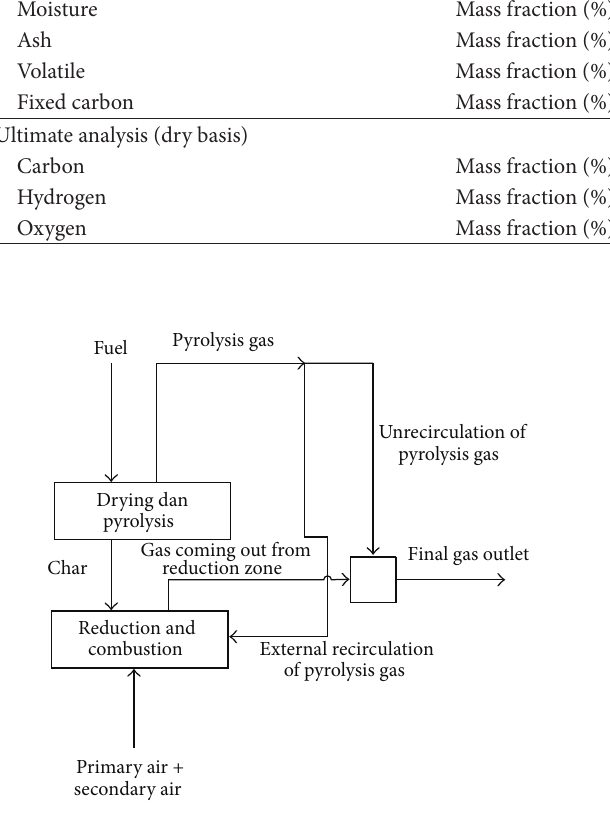
Figure 2: Configuration model updraft gasifier with external recir- culation of pyrolysis gas.